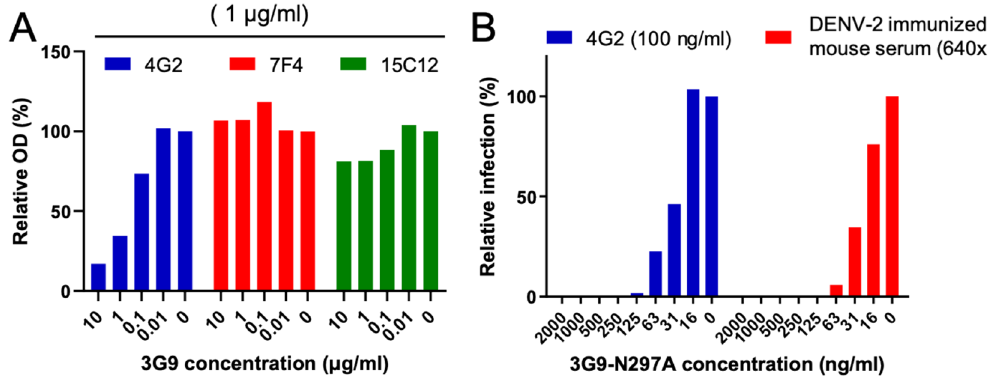
Figure 6. Competition ELISA and ADE assay. ( A ) Competition ELISA. Mouse monoclonal antibodies 4G2, 7F4, or 15C12 at 1 μg/ml were mixed with serially diluted 3G9 and incubated in a DENV-coated ELISA plate. The OD relative to that of the no competition well (without 3G9) is shown. Each data represents the average of two independent experiments. ( B ) Competition ADE. 100 ng/ml of 4G2 and 1:640 diluted mouse serum, which showed the peak level of enhancement, were mixed with DENV-2 NGC and serially diluted 3G9-N297A. The number of infected cells relative to that of the no competition wells is shown. Each data represents the average of two independent experiments.